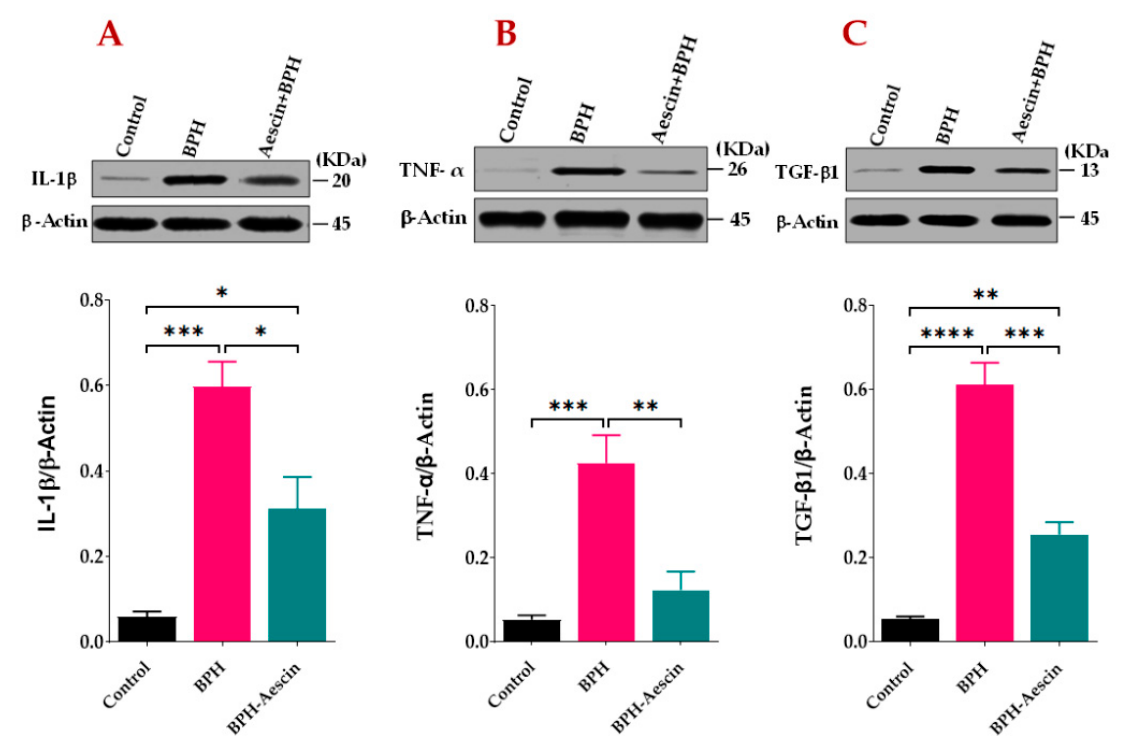
Figure 5. Aescin attenuates the testosterone-induced expression of IL-1 β , TNF- α , and TGF- β 1 in the prostate. Prostate tissue samples harvested from control, BPH, and BPH–aescin groups were homogenized in lysis buffer containing protease inhibitor cocktail and further processed for SDS-PAGE followed by Western blotting on nitrocellulose membranes as described in Section 4 Materials and Methods. The membranes were probed with mouse monoclonal antibodies against IL-1 β ( A ), TNF- α ( B ), or TGF- β 1 ( C ), and the protein expression was normalized by β -actin. The immunoblots (upper panel) are representations of 4 independent experiments. Data (Mean ± SEM, n = 4) were analyzed by one-way ANOVA followed by Tukey’s multiple comparisons test (lower panel). *, **, ***, and **** denote significant differences between the selected study groups at p values < 0.05, 0.01, 0.001, and 0.0001, respectively.